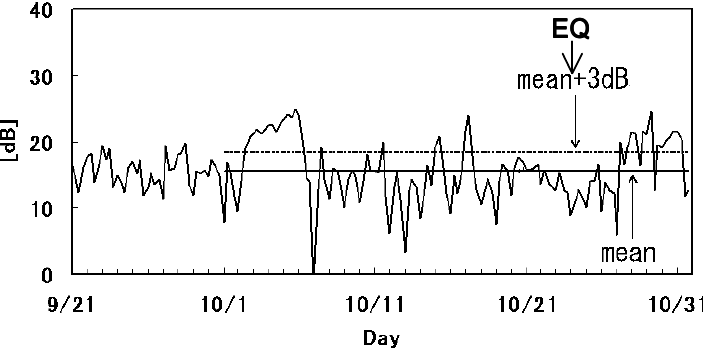
Figure 9. Temporal evolution of magnetic field intensity at Nakatsugawa. The frequency is less than 0.1 Hz. Strong emissions are observed from October 2 to 6. EQ indicates the earthquake time.